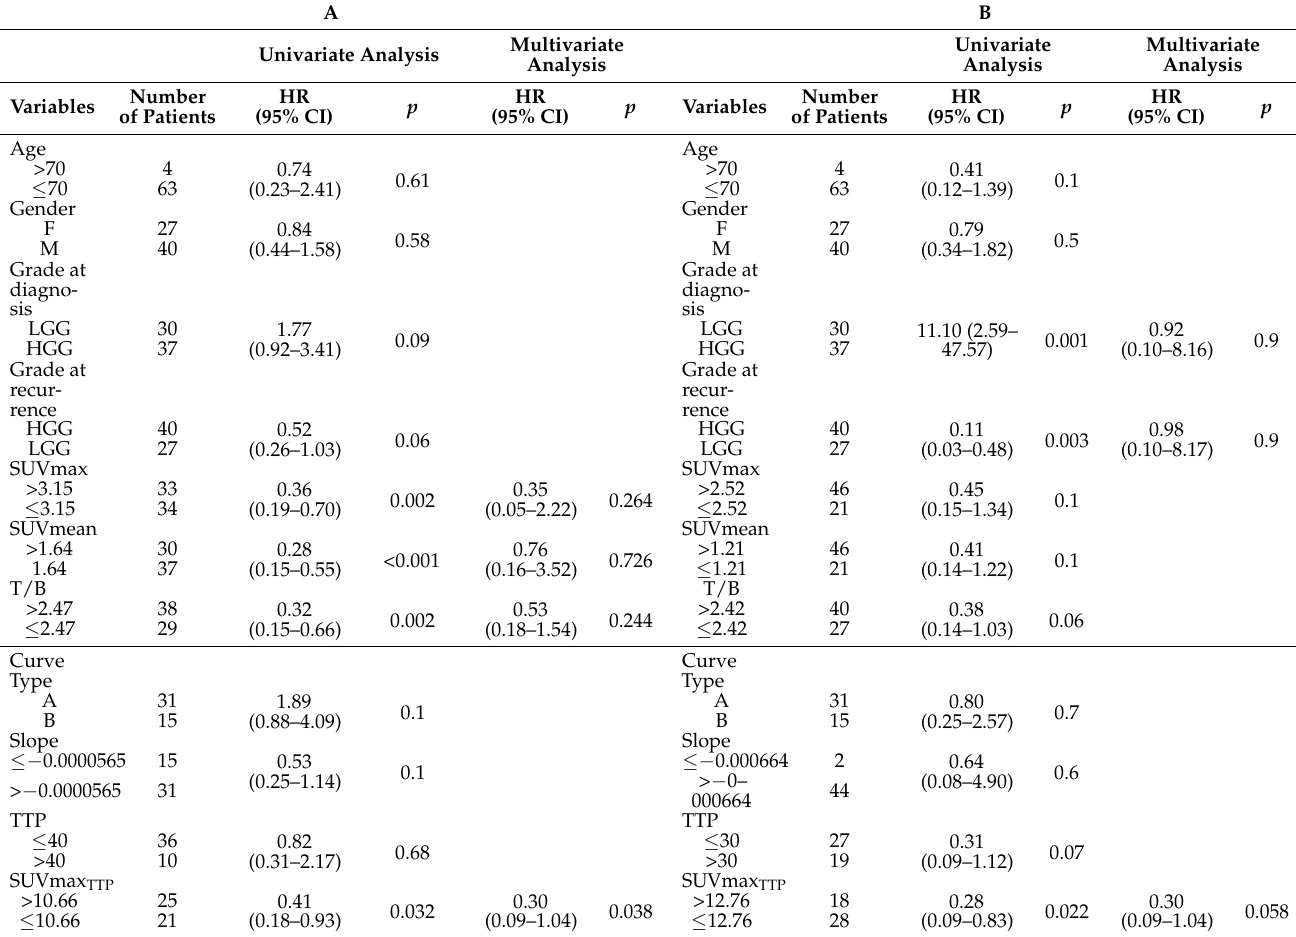
Table 7. Prognostic factors related to progression-free survival (A) and overall survival (B) univariate and multivariate analyses.